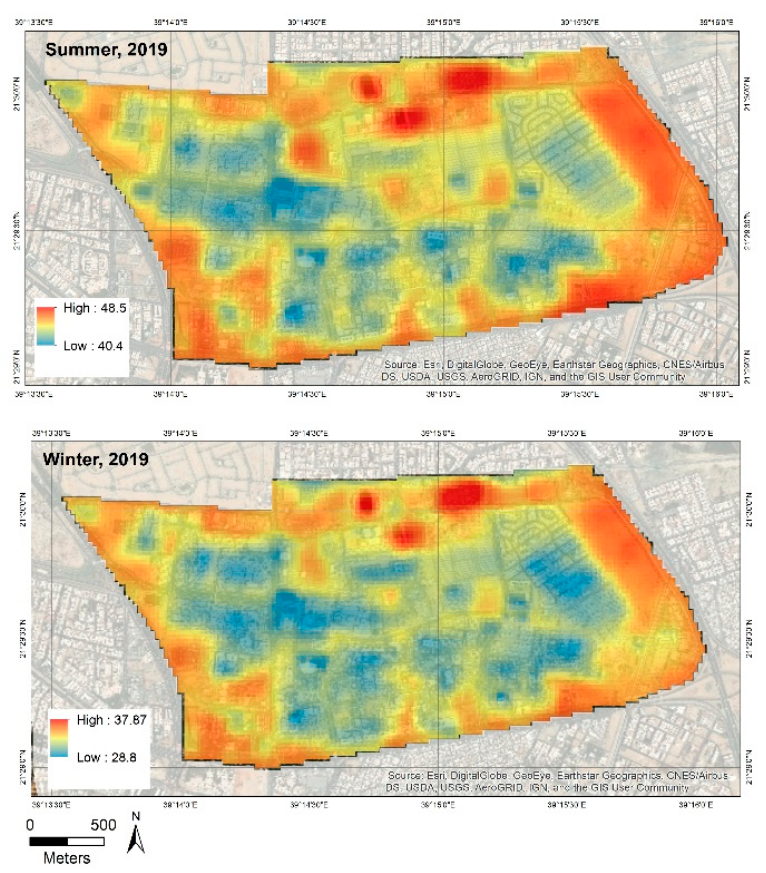
Figure 4. Estimated LST over King Abdulaziz University (KAU) campus during summer ( top ) and winter ( bottom ) 2019. Units are in degrees Celsius (°C).